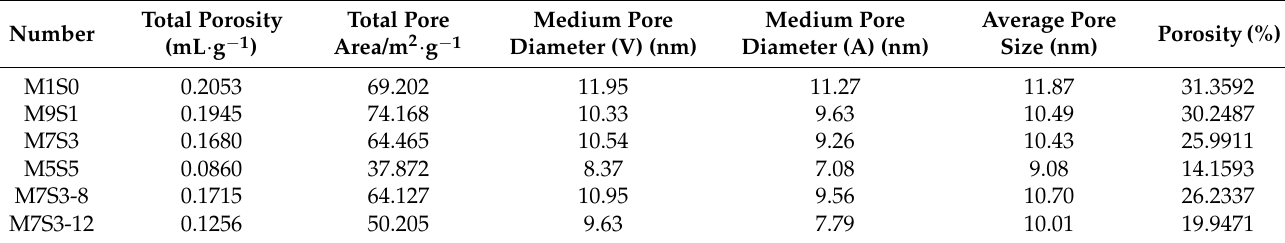
Figure 10. Distributions of pore sizes for AAMS composite cementitious materials. Table 4. Pore structure parameters for AAMS composite cementitious materials.